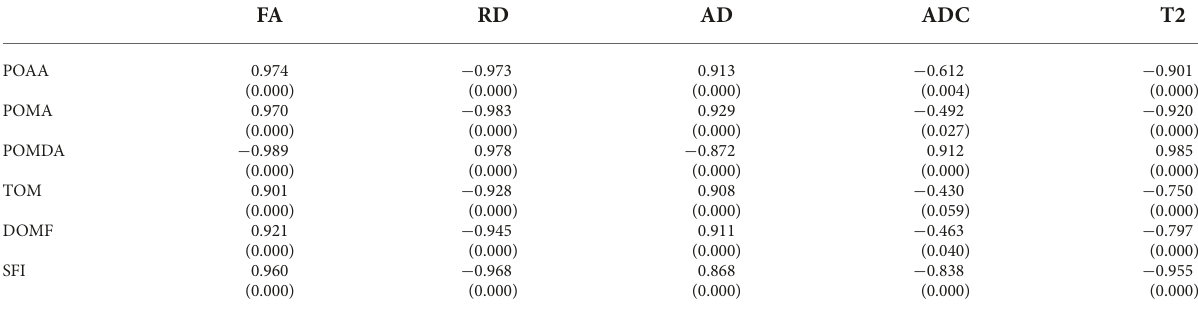
TABLE 6 Correlation coefficient between MRI and histological indexes of the distal stumps of injured